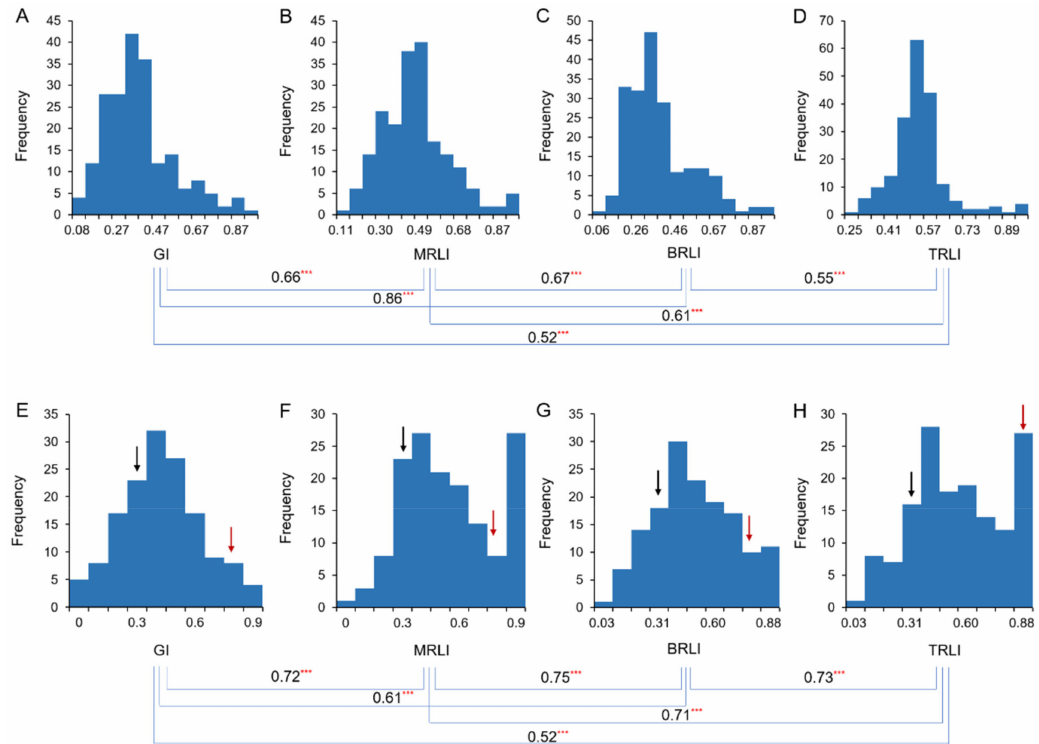
Figure 1. Distribution of drought indices for four drought-related traits at the germination stage in soybean. ***: p -value ≤ 0.001. ( A – D ) 201 soybean accessions. ( E – H ) MH population. Black arrows indicate ‘Hefeng25’, and red arrows indicate ‘Maple Arrow’ in each